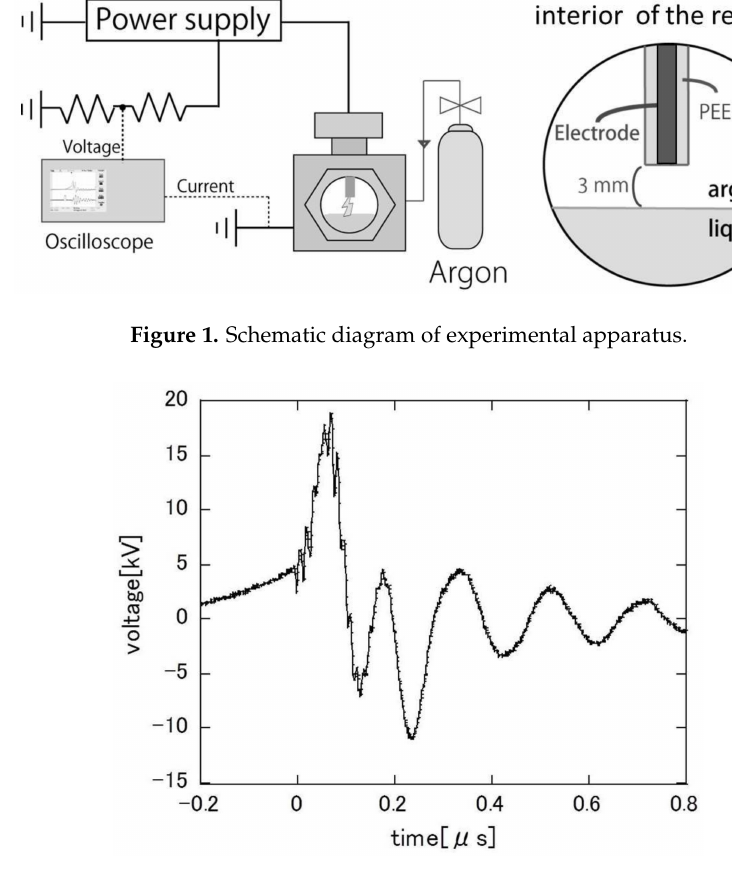
Figure 2. The waveform of nano-second pulse voltage applied at 18.6